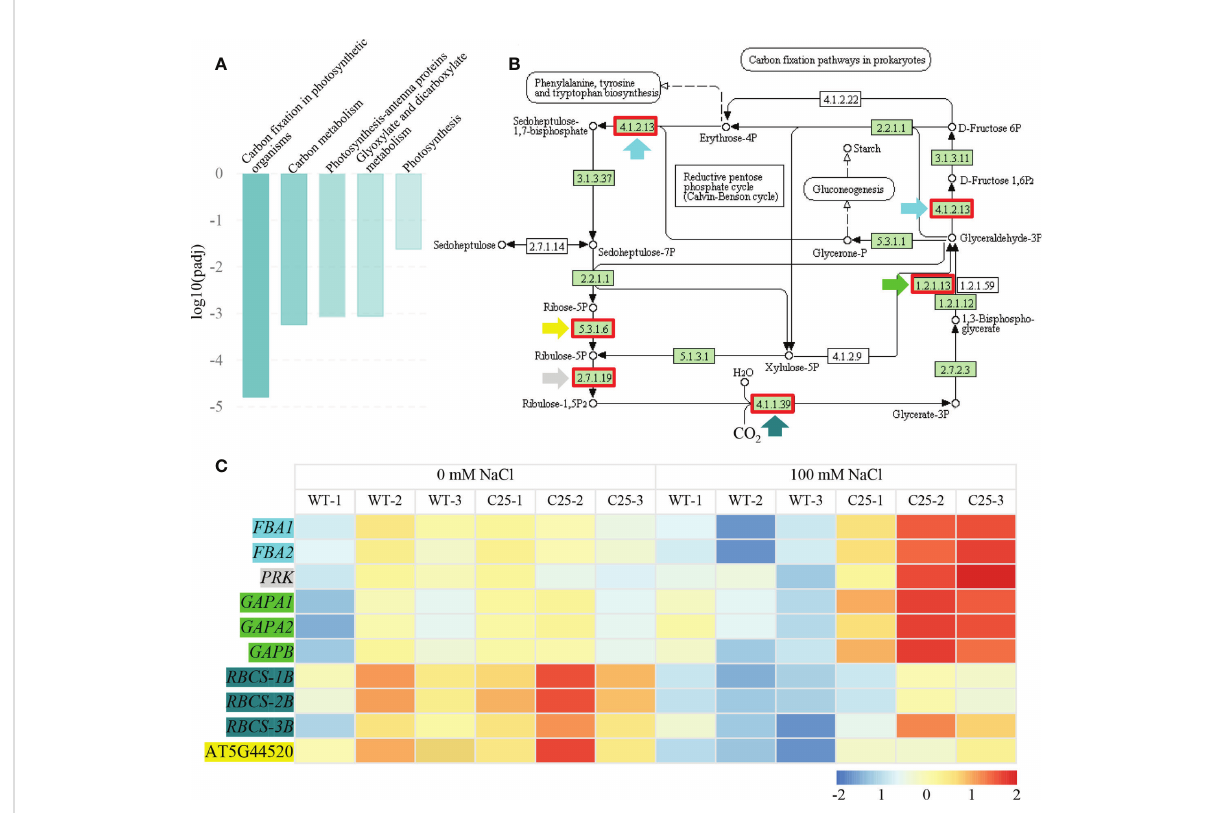
FIGURE 7 NbCIPK25 overexpression induces DEGs involved in photosynthesis. (A) KEGG enrichment of upregulated DEGs caused by NbCIPK25 overexpression under salt treatment. (B) The network of “ Carbon fi xation in photosynthetic organisms ” , red boxes indicate the up-regulated DEGs. Colored arrow heads are used to mark the names of DEGs in panel C. (C) The transcriptional trends of DEGs involved in “ Carbon fi xation in photosynthetic organisms ” shown as colored boxes with FPKM. Different color backgrounds under gene names correspond with colored arrow heads in Figure 7B, to indicate the corresponding location of genes in the pathway. FBA: Fructose-bisphosphate aldolase; PRK, Phosphoribulokinase; GAPA, Glyceraldehyde 3-phosphate dehydrogenase; RBCS, Ribulose-1,5-bisphosphate